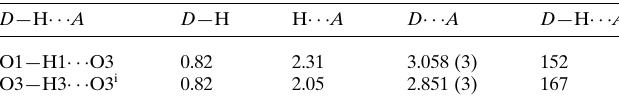
Table 1 Hydrogen-bond geometry (A˚ , (cid:4) ).